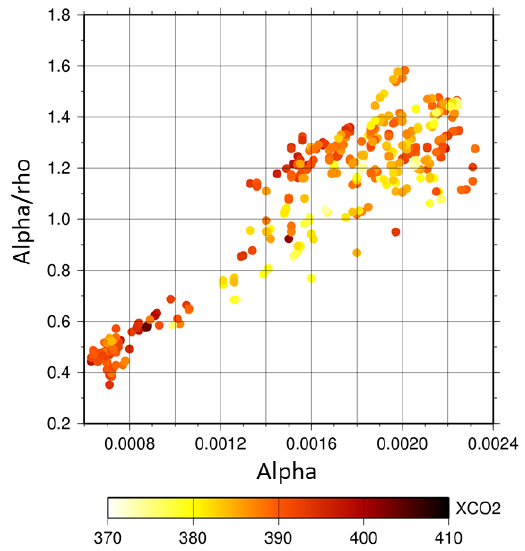
Figure 14. Correlation diagram between α a and α a / ρ a for GOSAT data observed over the target area in Western Siberia. The color represents retrieved XCO 2 .